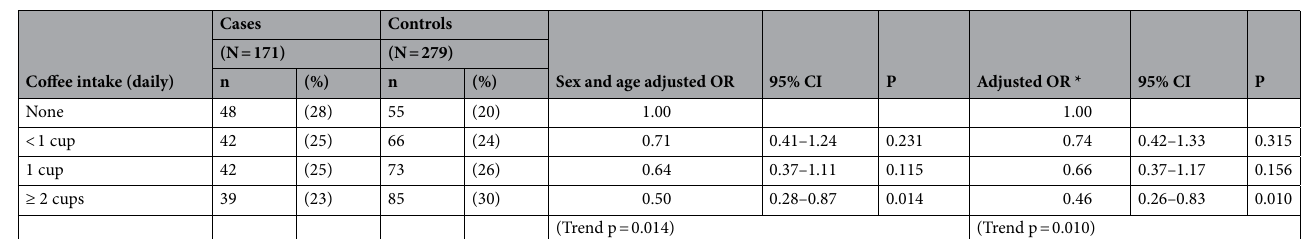
Table 5. Odds ratio of coffee intake for pneumonia excluding subjects with diabetes mellitus (sensitivity analysis) (N = 450). *Variables included in model: sex, age, vaccination status (pneumococcal, influenza),